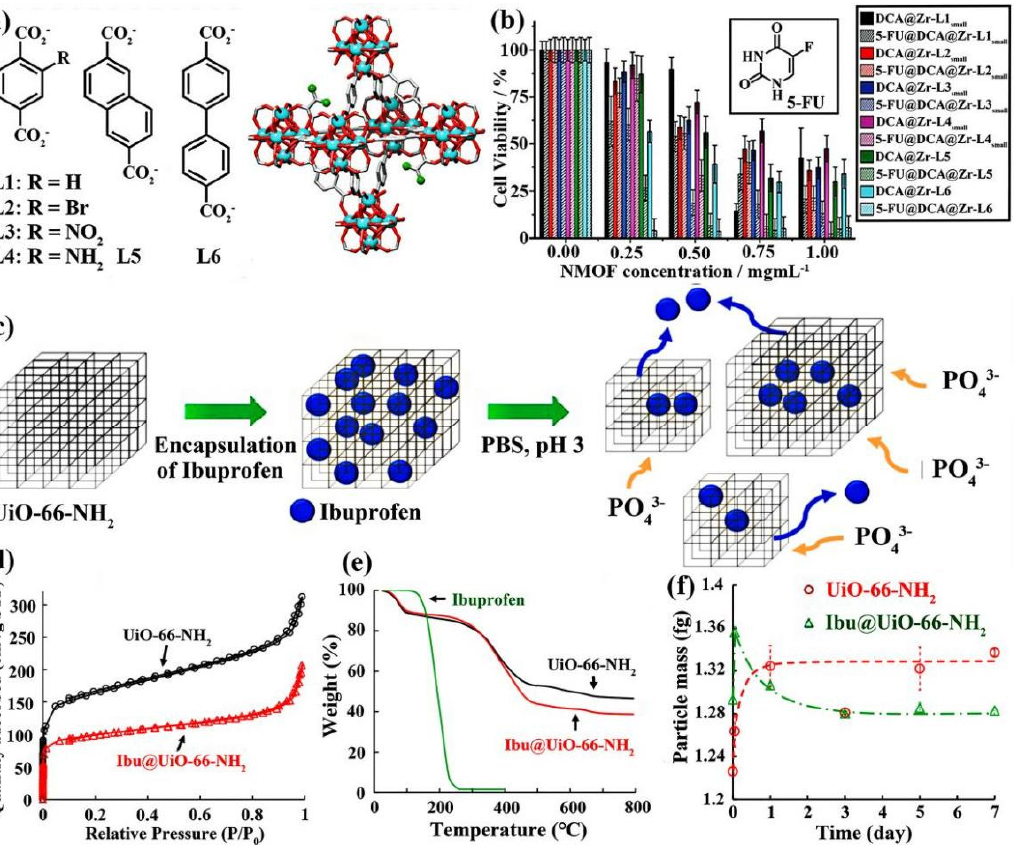
Figure 1. Defective Zr-MOFs: ( a ) Structure and ( b ) cell viability. Reproduced with permission from Ref. [68], copyright (2018) the Royal Society of Chemistry. ( c ) Preparation of Ibu@UiO-66-NH 2 and its application. ( d – f ) Characterization and drug release of UiO-66-NH 2 and Ibu@UiO-66-NH 2 . Reproduced with permission from Ref. [69], copyright (2019) the American Chemical Society.